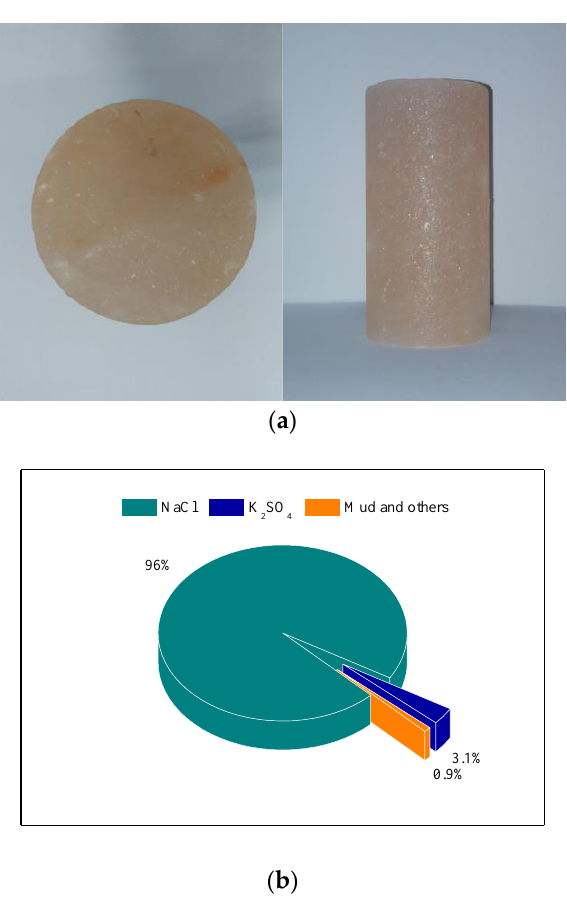
Figure 3. ( a ) The real rock salt samples. ( b ) Components of rock salt used in the tests.